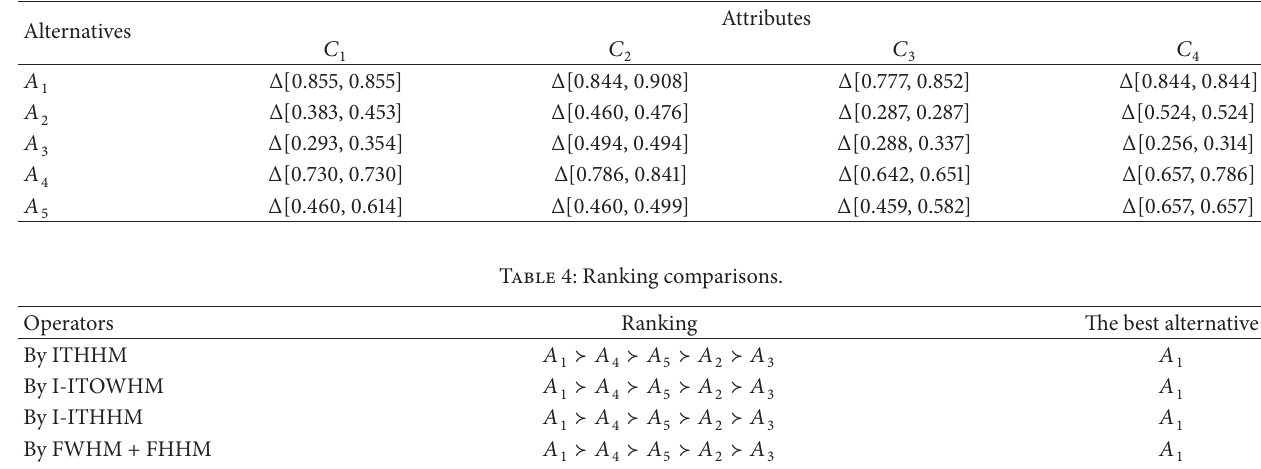
Table 3: Collective decision matrix by I-ITHHM.